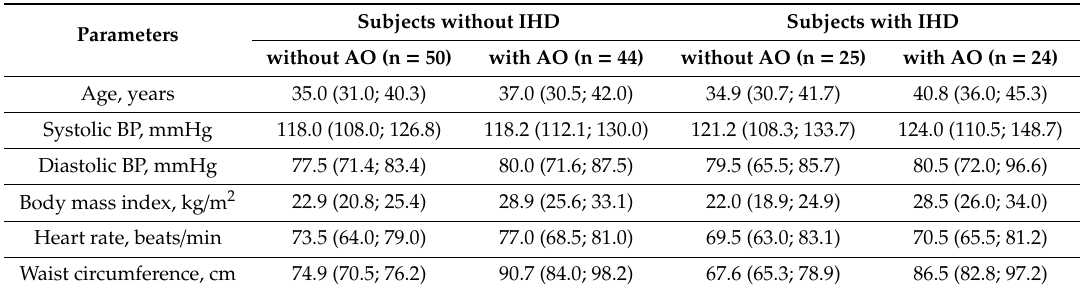
Table 1. Clinical and anthropometric characteristics of the subgroups under study (median (lower; upper